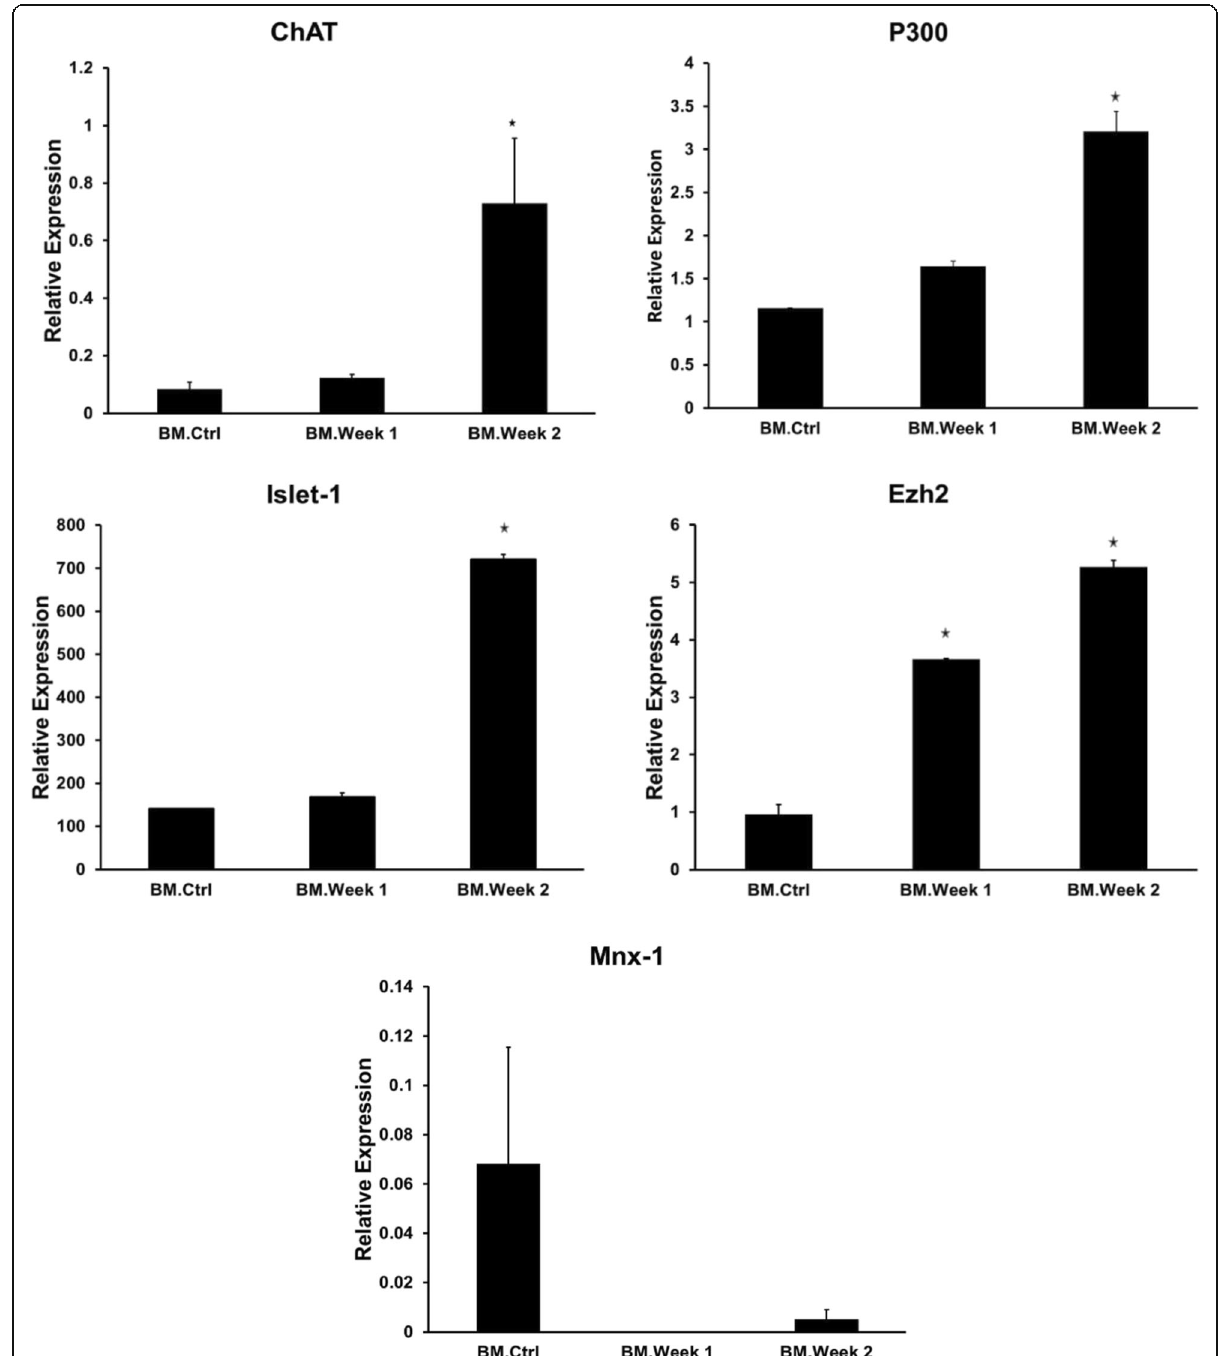
Fig. 3 Quantitative gene expression. The expression of ISLET-1 , ChAT , and MNX-1 was evaluated in human BM-MSCs at 7 and 14 days after induction in comparison with the control group (non-treated BM-MSCs) ( n =3; mean ± SE; p ≤ 0.05). The expression of motor neuron-related genes ( ISLET-1 and CHAT ) and histone-modifying enzyme genes ( P300 and EZH-2 ) was significantly upregulated at the second week of induction when RA and Shh were removed. Significant upregulation in the expression of EZH-2 was also detected at week 1 when the result was compared to the control. No upregulation was detected in the expression of MNX-1 when the results were compared with the